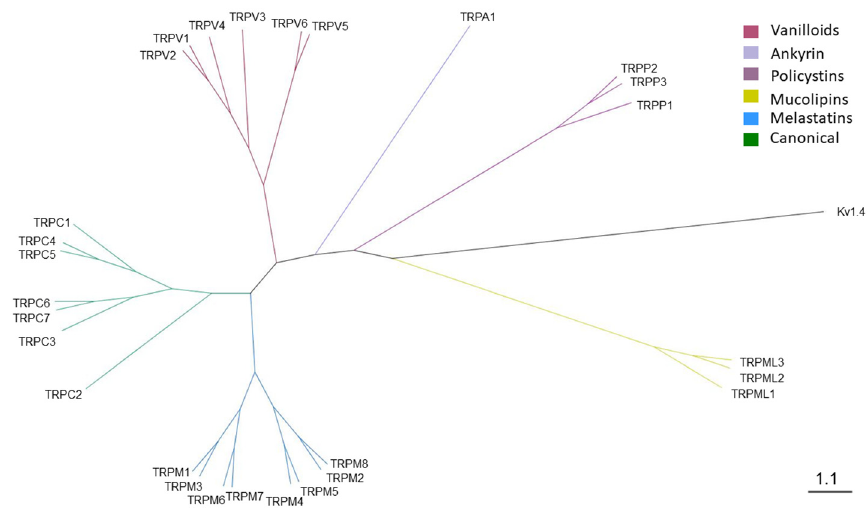
Figure 1. Phylogenetic tree of the canine transient receptor potential (TRP) ion channels family. Six different subfamilies, namely TRPC (canonicai), TRPM (melastatin), TRPV (vanilloid), TRPA (ankyrin), TRPP (policystin), and TRPML (mucolipin), were denoted in different colors. The tree was constructed using Bayesian analysis (four Markov chains, 100,000 generations, the tree sam- pling frequency of 500 and burning fraction 25%) of the available canine TRP ion channel protein sequences. Canine voltage-gated potassium channel Kv1.4 was used as an outgroup. Scale bar indicates branch length.